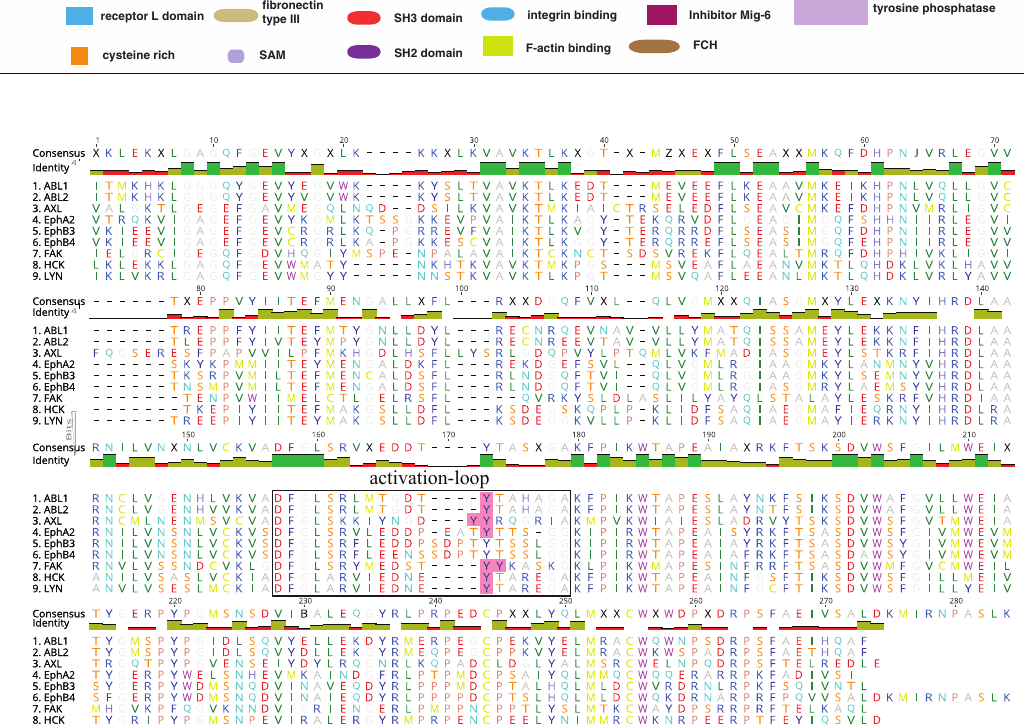
Figure 5. Site-specific regulation of tyrosine kinases and protein tyrosine phosphatases by AXL activation. ( A ). Schematic representation of receptor tyrosine kinases (top left panel), non-receptor tyrosine kinases (top right panel) and protein tyrosine phosphatases (middle panel) along with phosphorylation sites regulated by AXL activation and the time course. Black bars with red filled circles at the end denote phosphorylation modification. The embedded column plots depict the regulation pattern of individual phosphotyrosine sites. The domain structures of the molecules are shown with the key in the panel at the bottom. ( B ). Multiple sequences alignment of the amino acid sequences of the tyrosine kinase domain of the RTKs and NTRKs regulated by Axl. The box indicates the activation loop of the kinase domain. Regulated phosphotyrosine residues identified in this study were highlighted in